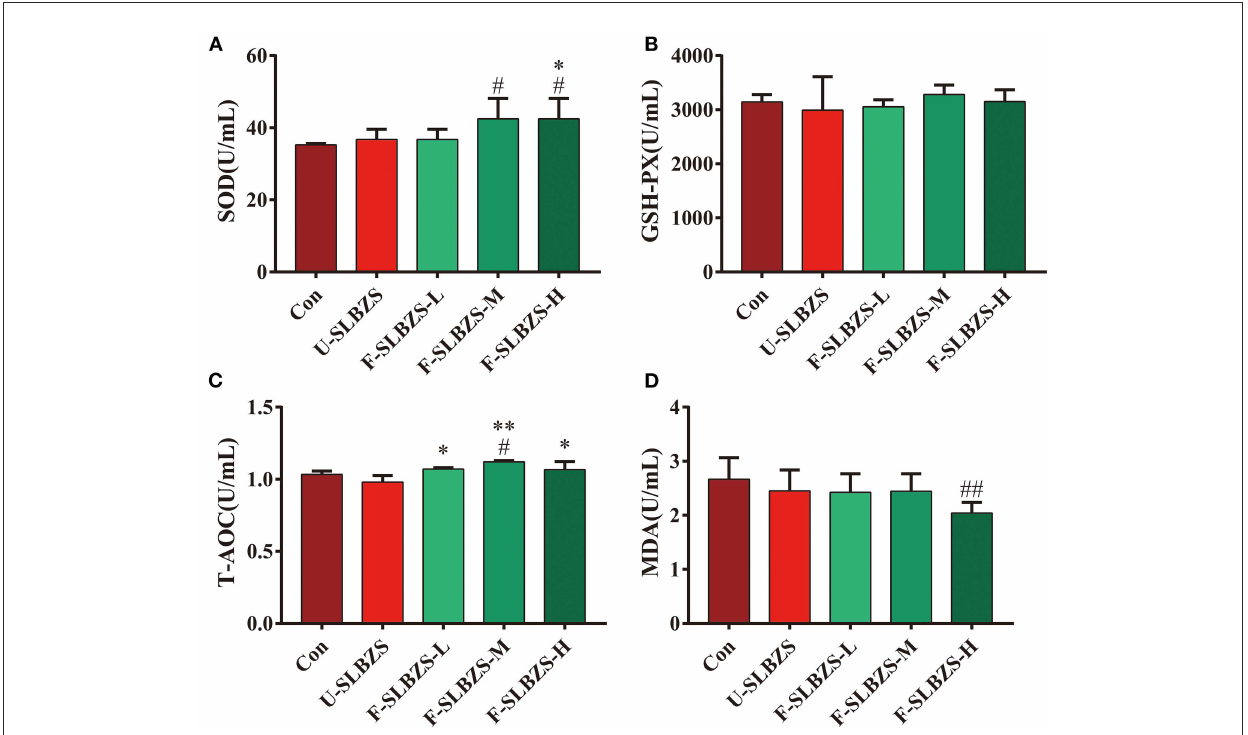
FIGURE4 Effects of fermented SLBZS on antioxidant factor content in broilers. (A) Content of SOD in serum of broilers. (B) Content of GSH-PX in serum of broilers. (C) Content of T = AOC in serum of broilers. (D) Content of MDA in serum of broilers. Bars represent mean values ± SD ( n = 3-5). # and ## indicate p < 0.05 and p < 0.01 compared with the Con group, * and ** indicate p < 0.05 and p < 0.01 compared with the U-SLBZS